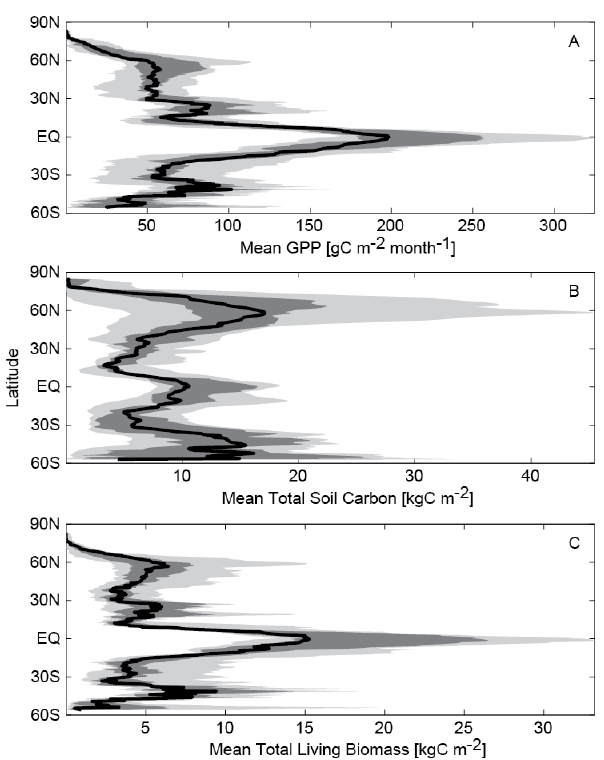
Figure 6 Fig. 6. Global steady-state GPP, total soil carbon, and total living biomass for 10 MsTMIP models (Biome-BGC, CLM, CLM4VIC, GTEC, LPJ-wsl, ORCHIDEE-LSCE, TRIPLEX-GHG, VEGAS, and VISIT) from the RG1 simulation. The solid black line shows the median of the multi-model ensemble, the darker grey shaded area shows the interquartile range; and the lighter grey band shows the full range in estimates.